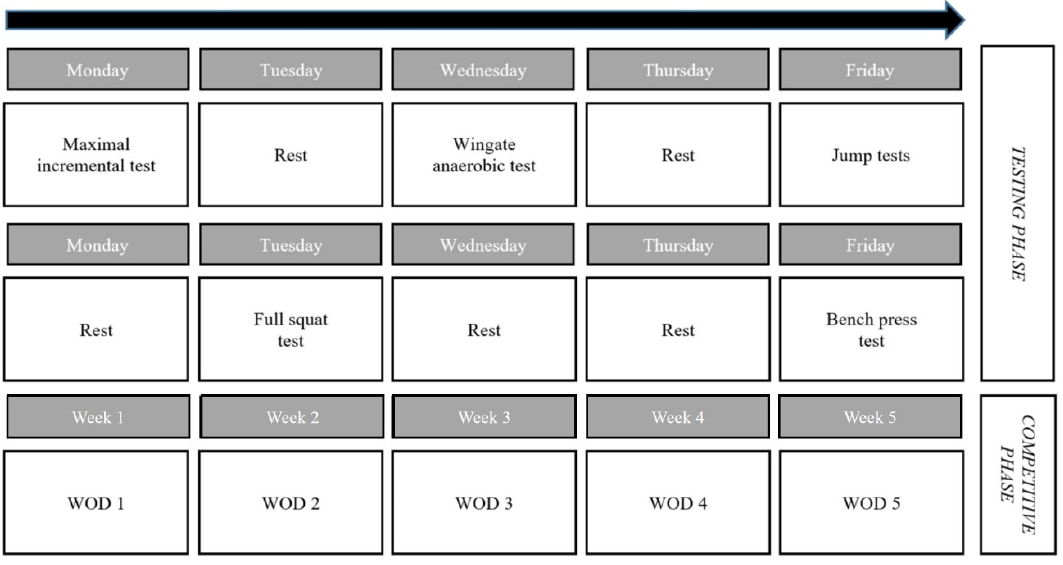
Figure 1. Schematic representation of the study protocol. Abbreviation: WOD, workout of the day.